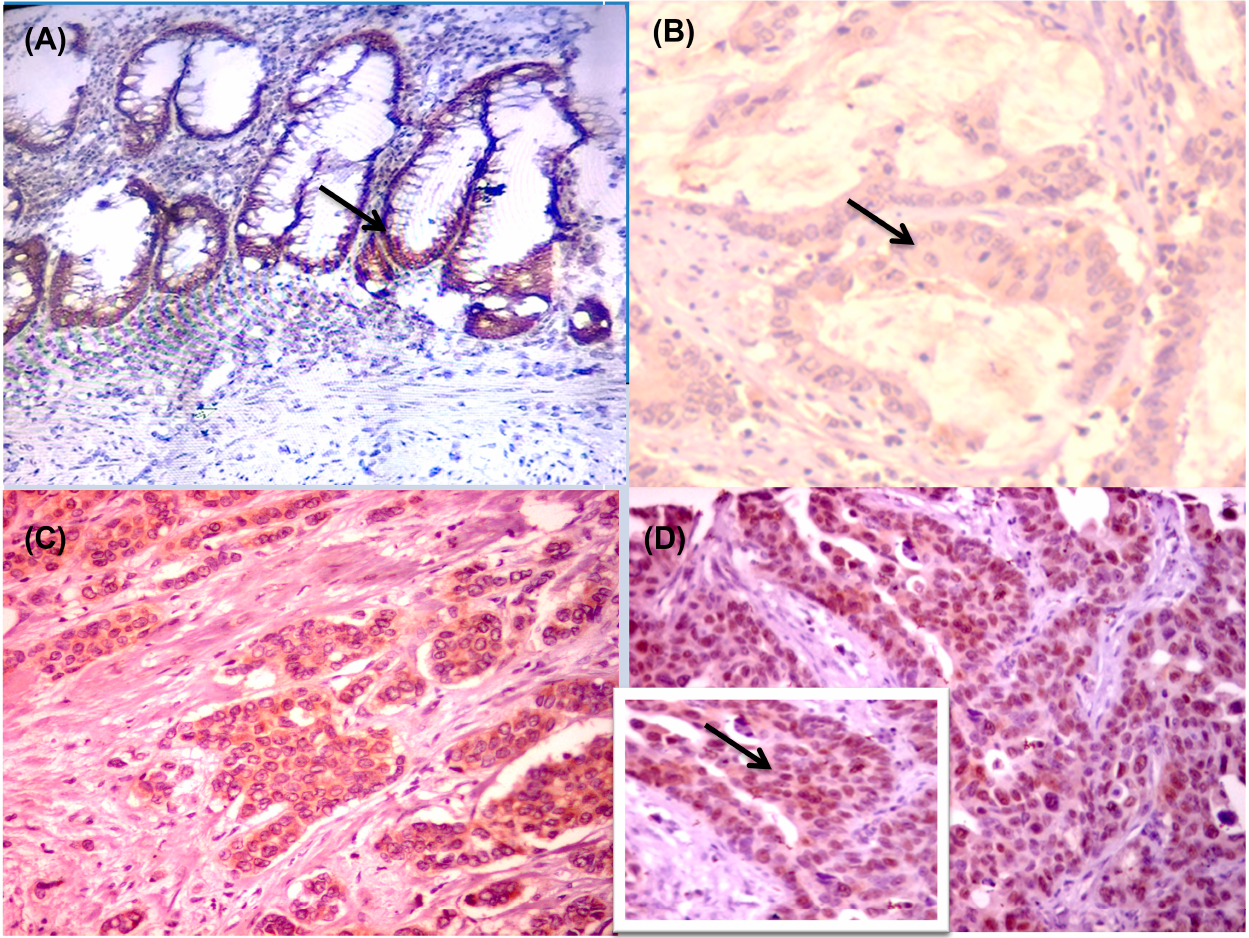
Figure 2. Immunohistochemical staining of colonic adenocarcinoma for BRAF protein showed aberrant cytoplasmic expression in the adjacent non-neoplastic colonic mucosa (( A ) × 200). Colonic adenocarcinoma did not express staining for BRAF protein (( B ) × 400), colonic adenocarcinoma expressed diffuse strong cytoplasmic staining (( C ) × 200), while other colonic adenocarcinoma showed diffuse strong cytoplasmic staining associated nuclear staining for BRAF protein (( D ) ×